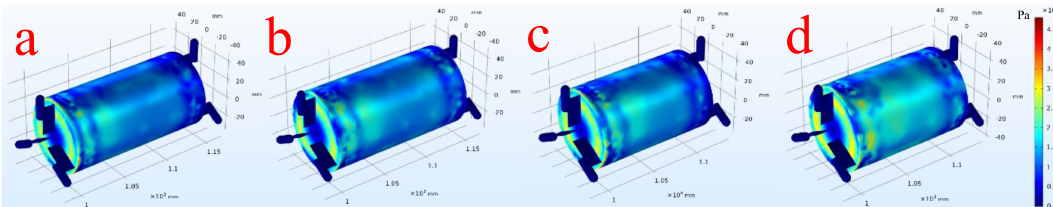
Figure 12. Wall shear stress distribution for di ff erent sizes of piped carriage with the discharge of 50 m 3 · h − 1 . Note: ( a ) D c × L c = 75 mm × 150 mm; ( b ) D c × L c = 80 mm × 150 mm; ( c ) D c × L c = 75 mm = 80 mm × 120 × 120 mm; ( d ) D × L c c